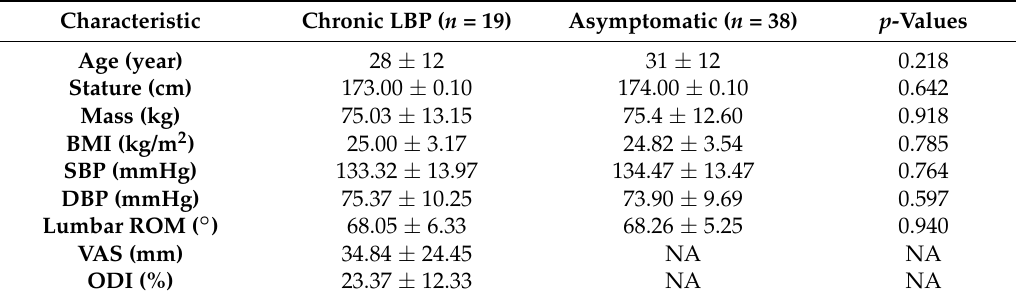
Table 1. Participant demographics and descriptive